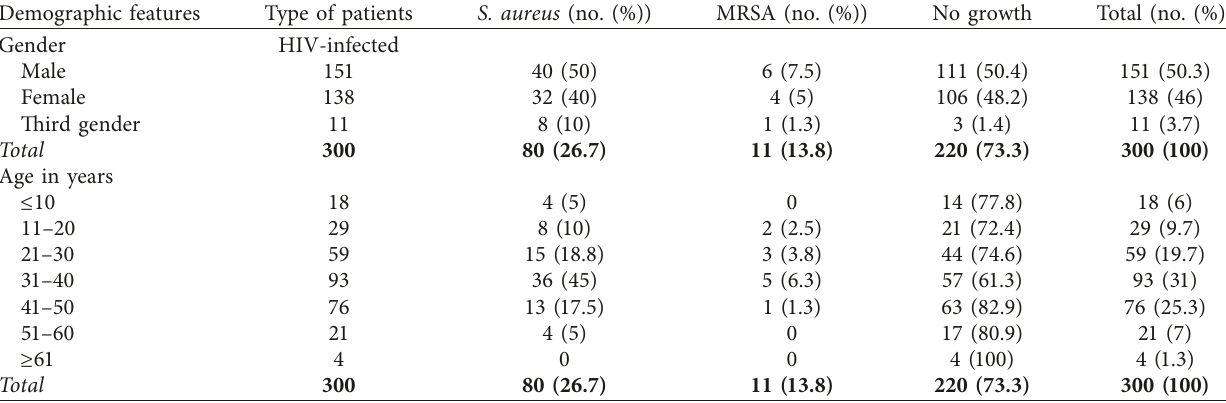
Table 1: Socio demographic characteristics of the HIV-infected patients and ratio of S. aureus carriage.